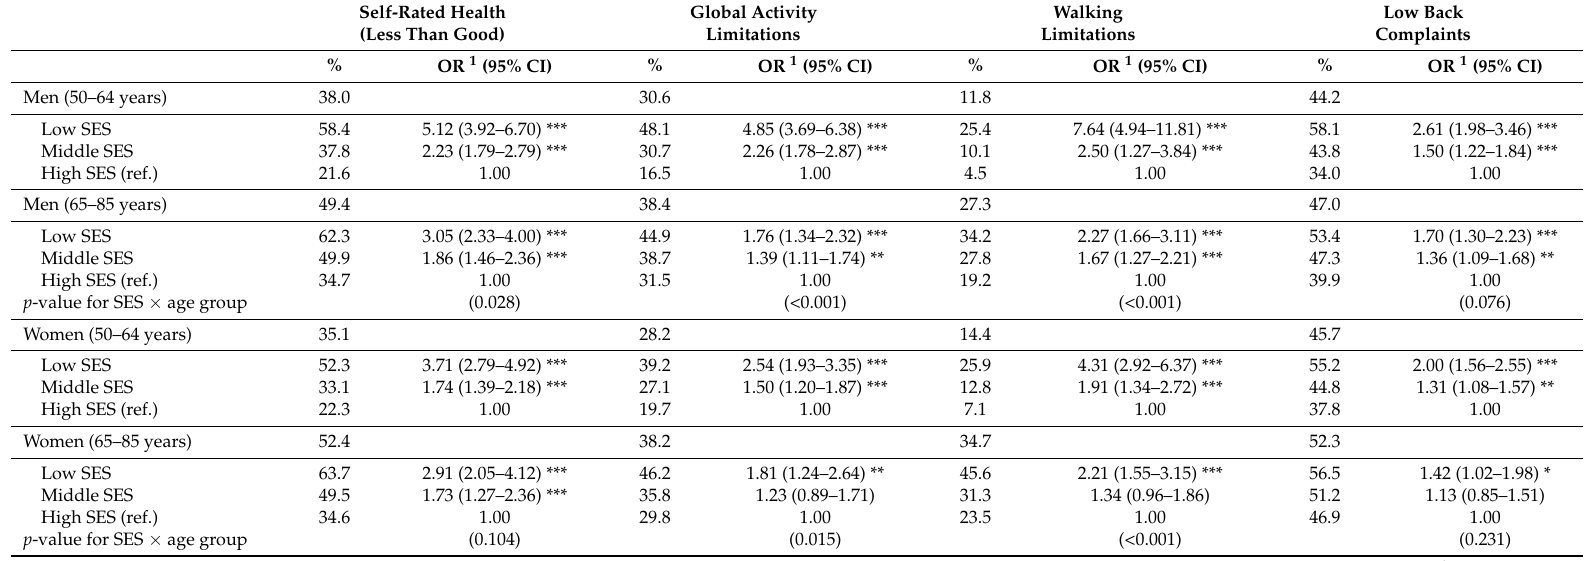
Table 2. Self-reported health problems among men and women in Germany, by socioeconomic status and age group. Self-Rated Health (Less Than Good)